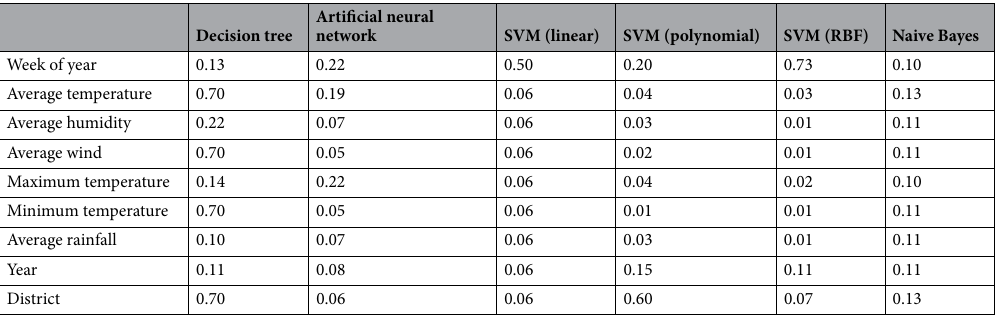
Table 1. Predictor importance of the models.